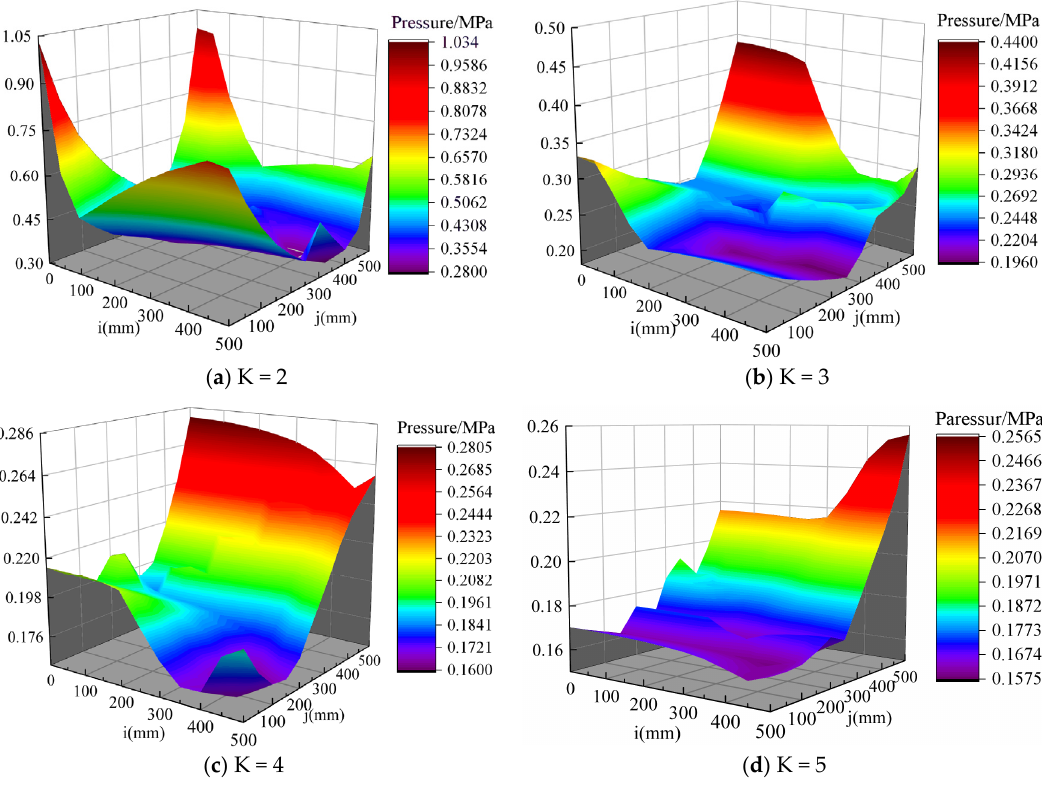
Figure 12. Distribution of peak pressure in the corner area at different values of K.